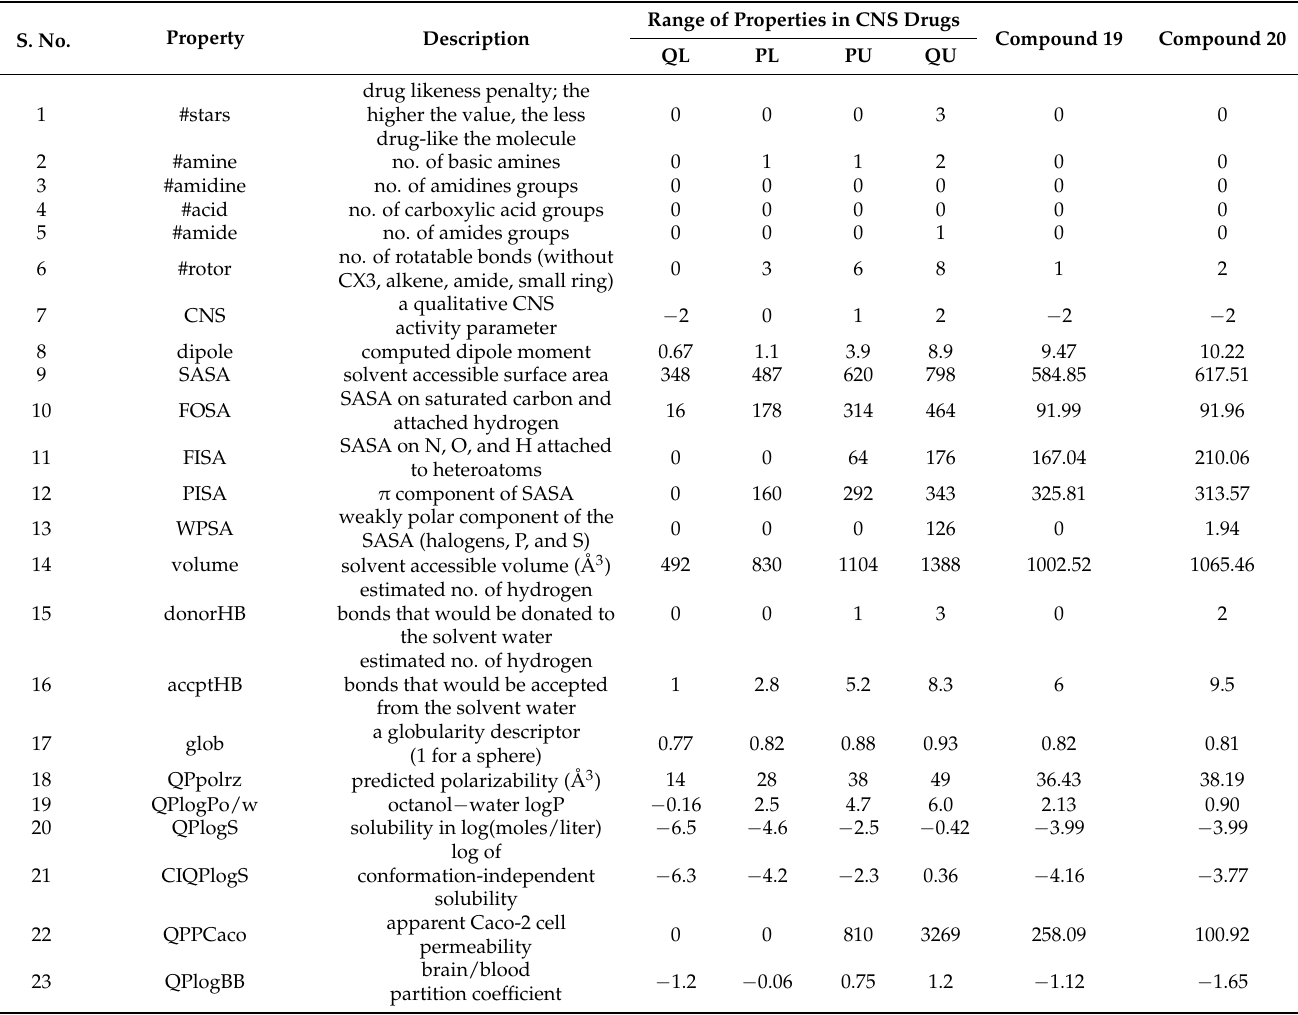
Table 2. Physicochemical and pharmacokinetic properties of compounds 19 and 20 , predicted by QikProp, Schrodinger, for CNS